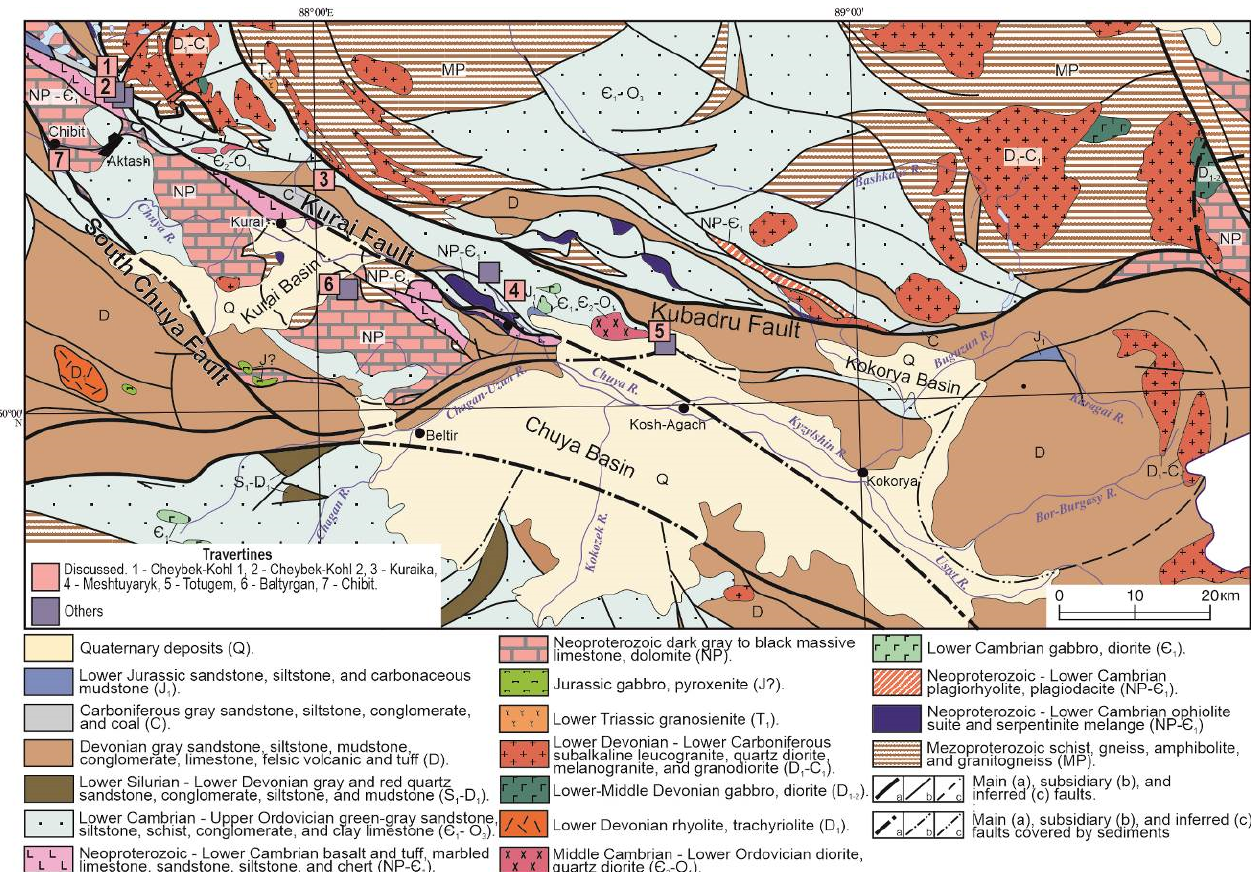
Figure 2. Geological map of the south-western Gorny Altai (simplified from [73]), showing locations of travertine occurrences.